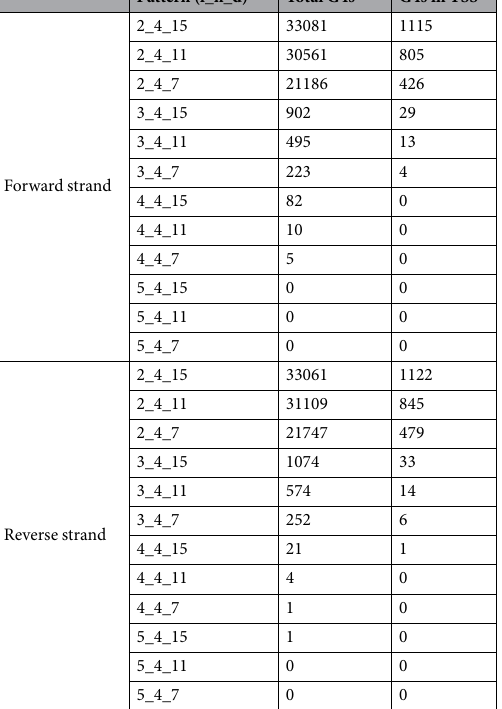
Table 1. Number of putative G4s in both strands of the Mtb genome within 50 nts upstream of a primary TSS. Position of the found G4s in the Mtb genome is available in Supplementary Files S1a and